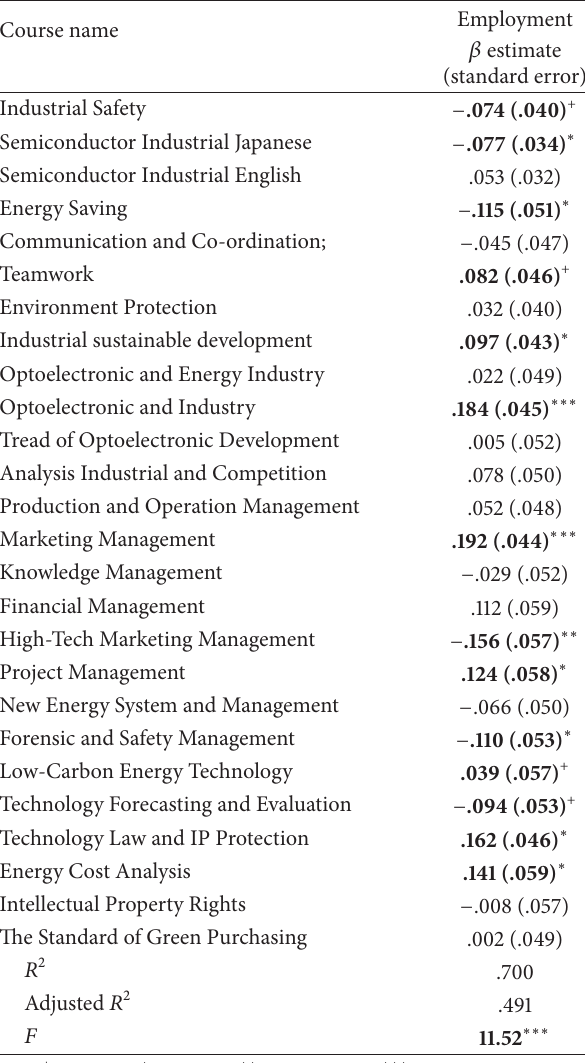
Table 15: Multiple regression analysis—affective domain curricu- lum on employability (industry